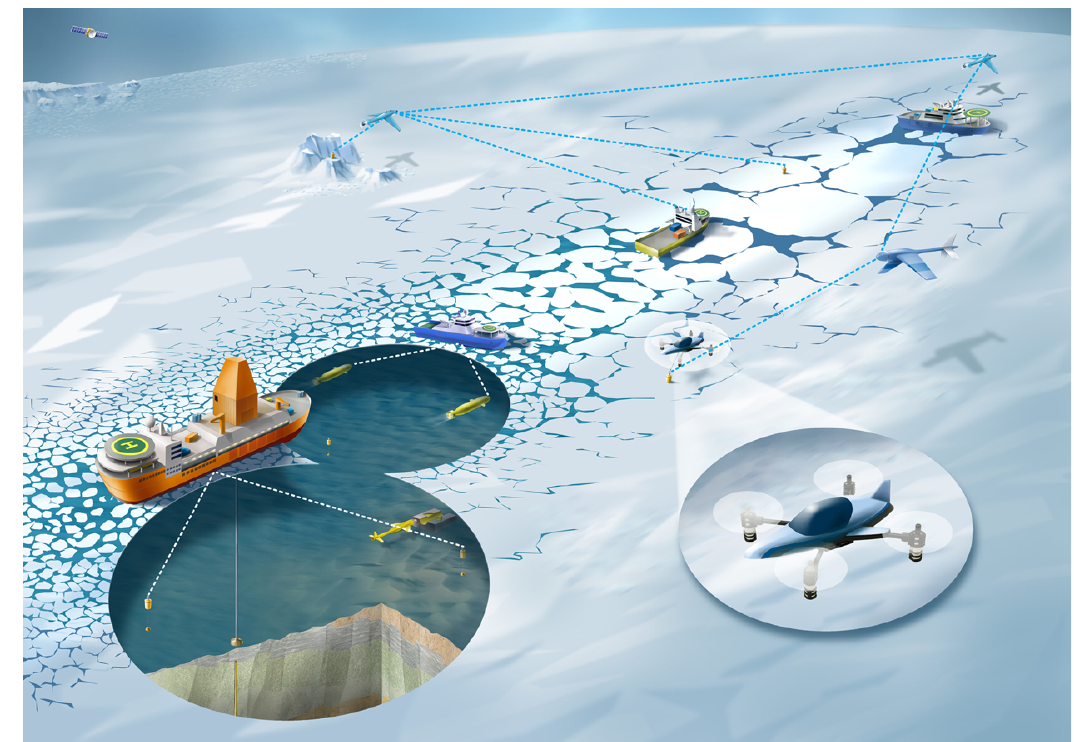
Figure 6: Foreseen Arctic DP operation with a sophisticated Ice Management System. Three icebreakers manage the upstream incoming ice to reduce loads on the protected vessel, which here is an Arctic drillship. A future-oriented autonomous ice surveillance system is illustrated to measure and communicate ice and metocen information from various stationary sensors and a satellite, aerial drones, and underwater vehicles as mobile sensor platforms. Copyright: NTNU, Illustration: Bjarne